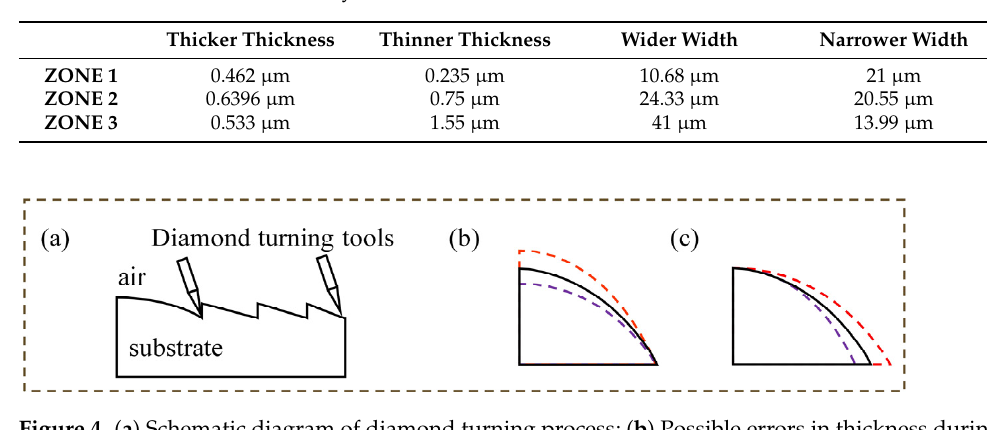
Table 3. Data of HMID sensitivity.